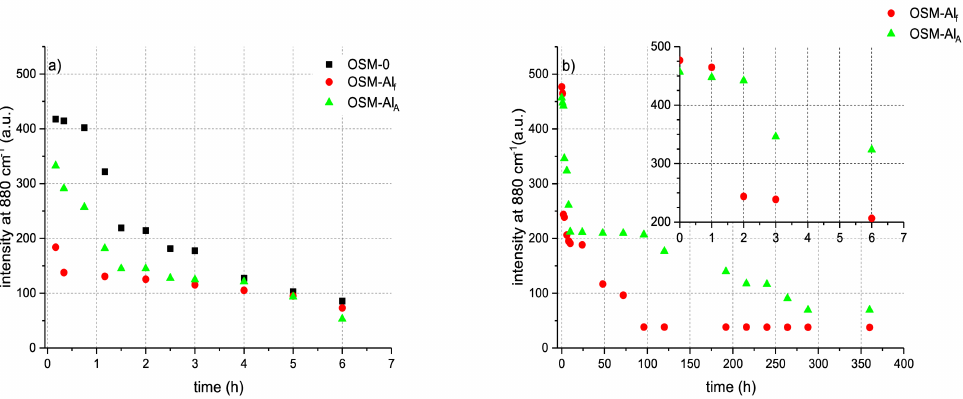
Figure 4. Evolution of the signal at 880 cm − 1 . Symmetric vibration between O–O in hydrogen peroxide molecules, as a function of time for tested OSM for ( a ) 10 g OSM and ( b ) 500 g OSM; Inset: magnification of signal changes for 500 g OSM charges, taking place over the first 6 h of the experiment, for comparison with panel